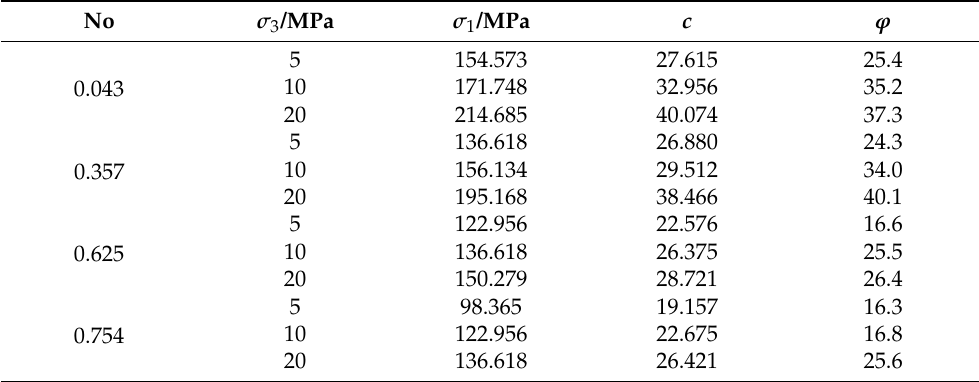
Table 7. Triaxial test data of different initial damages and confining pressures.